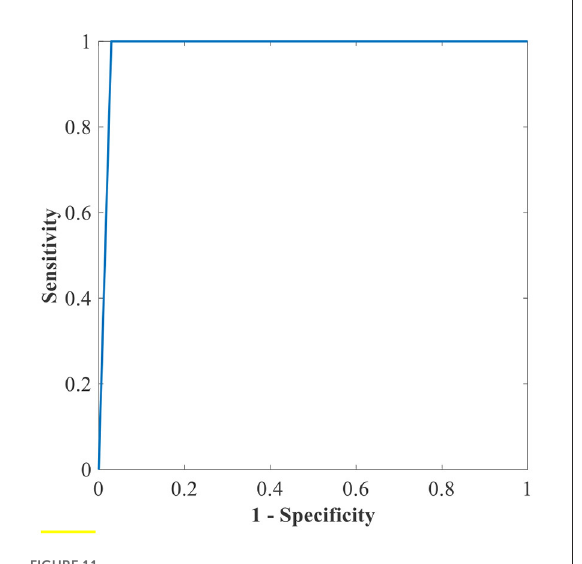
FIGURE11 The ROC of the highest binary classification outcome for the GWO-ELM approach using the IDRiD